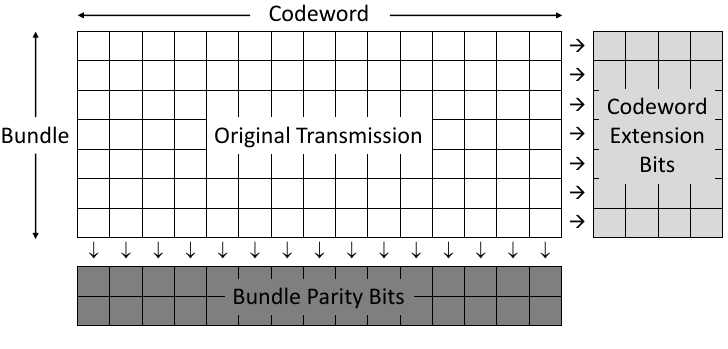
Figure 2. Types of incremental